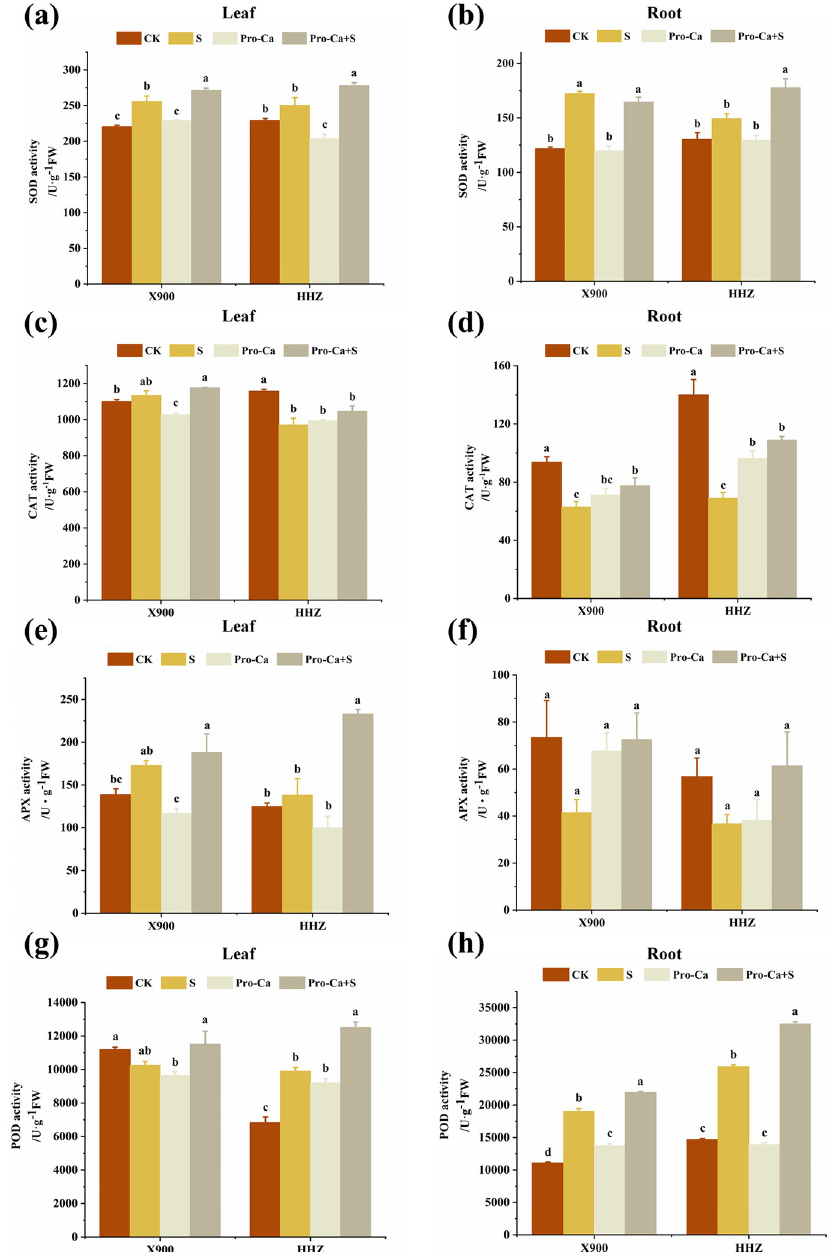
Fig 5. The alleviating effect of exogenous prohexadione-calcium (Pro-Ca) on the antioxidant enzyme activity of rice under salt stress. The superoxide dismutase (SOD) activity in the X900 (left) and HHZ (right) leaves (a) and roots (b); The katalase (CAT) activity in the X900 (left) and HHZ (right) leaves (c) and roots (d); The ascorbate peroxidase (APX) activity in the X900 (left) and HHZ (right) leaves (e) and roots (f); The peroxidase (POD) activity in the X900 (left) and HHZ (right) leaves (g) and roots (h). Abbreviations: CK (water spraying + 0% NaCl), S (water spraying + 0.3% NaCl), Pro-Ca (100 mg � L -1 Pro-Ca leaf spraying + 0.3% NaCl), and Pro-Ca + S (100 mg � L -1 Pro-Ca leaf spraying + 0.3% NaCl). The numerical value represents the mean ± SE ( n = 3), and different lowercase letters indicate significant differences according to Duncan’s test ( p < 0.05).